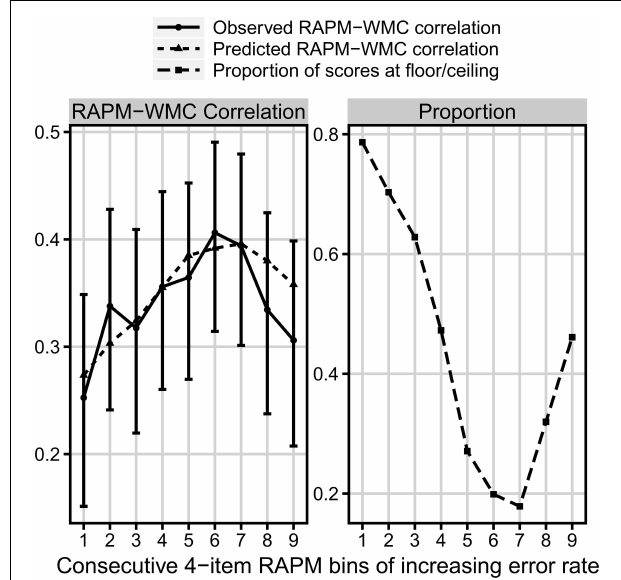
FIGURE 6 | Comparison of three measures as a function of the consecutive bins increasing in difficulty. Left: the observed (solid line) and predicted (dotted line) bin correlation with WMC (measured with the complex span tasks). Right: the proportion of floor/ceiling effect (dashed line). N